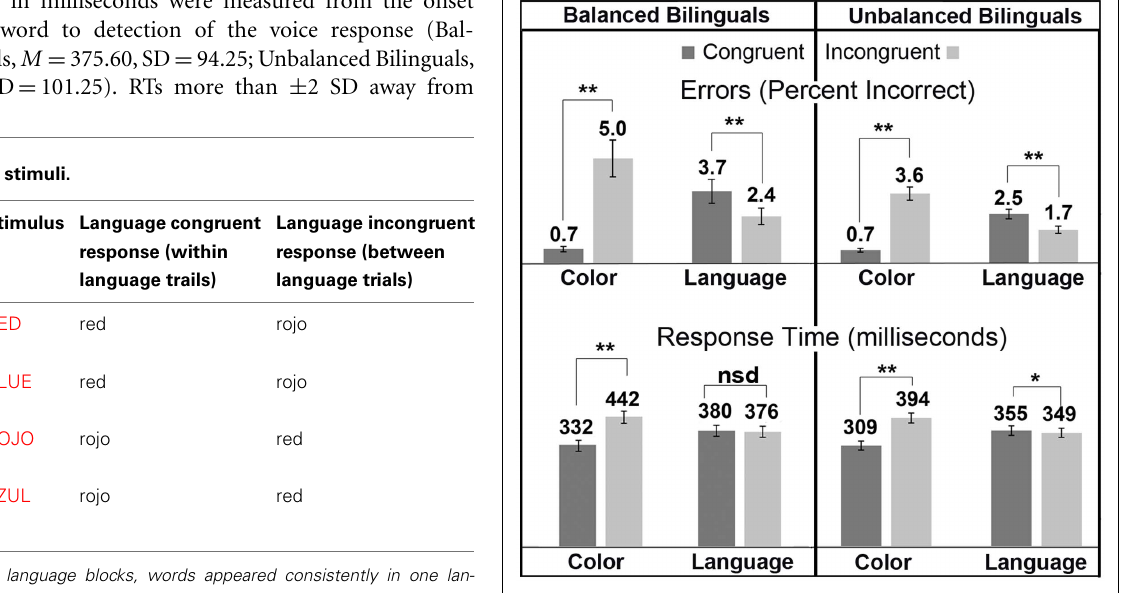
FIGURE 1 | Main effects of color congruence and language congruence from Experiment 1. Mean proportion of incorrect responses and